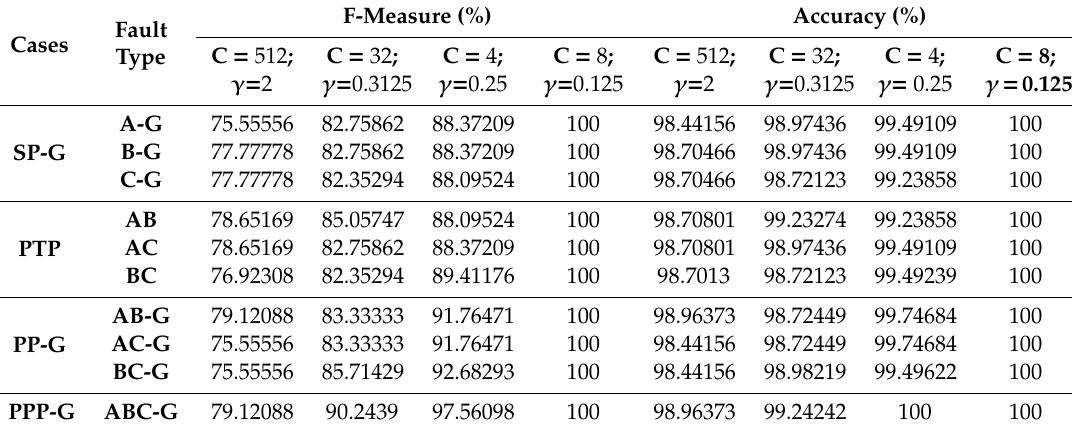
Table 3. Support vector machine (SVM) classification results at di ff erent values of parameters C and γ .